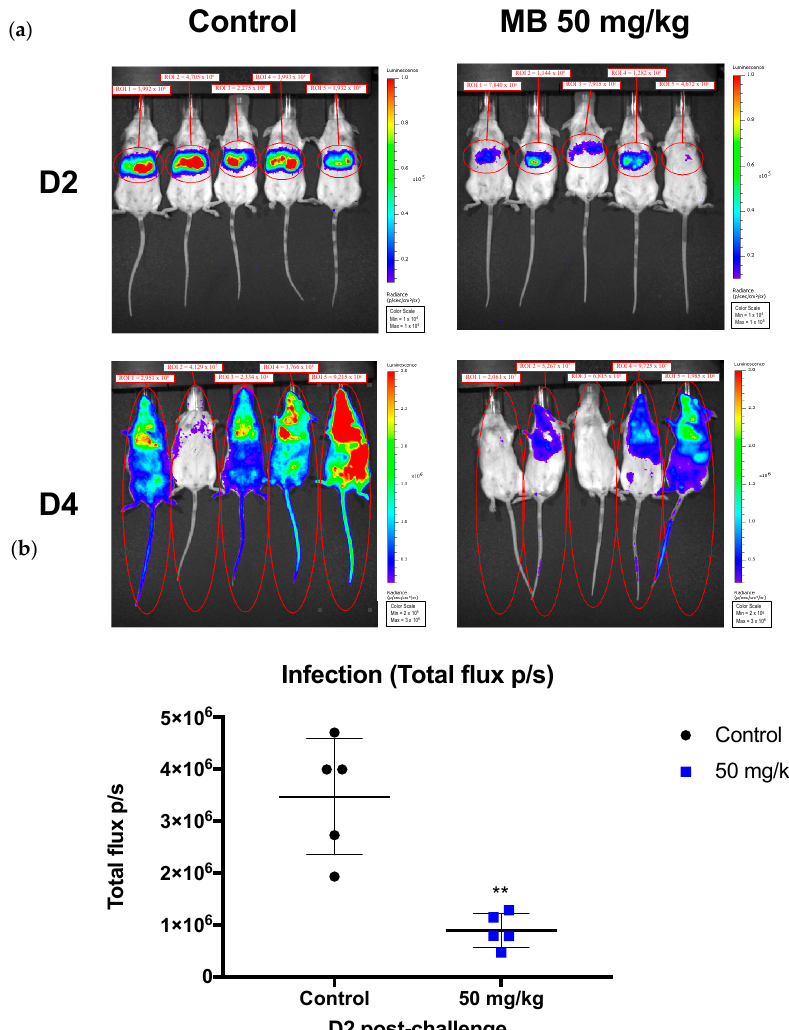
Figure 5. MB delayed and reduced the P. yoelii sporozoite infection in mice. Mice were first treated for 30 min with MB (50 mg/kg) and were then challenged by retro-orbital injection of 5.000 sporozoites of P. yoelii. ( a ) In vivo images (IVIS) of luminescence reported at D2 and D4 post- P.yoelii -infection. Rainbow images show the relative levels of luminescence ranging from low (blue) to medium (green) to high (yellow/red). ( b ) Mean luminescence levels (photons/s) for each group at 42 h post-challenge. The black lines represent the mean and standard deviation. ** p = 001 when compared to control by t -test.